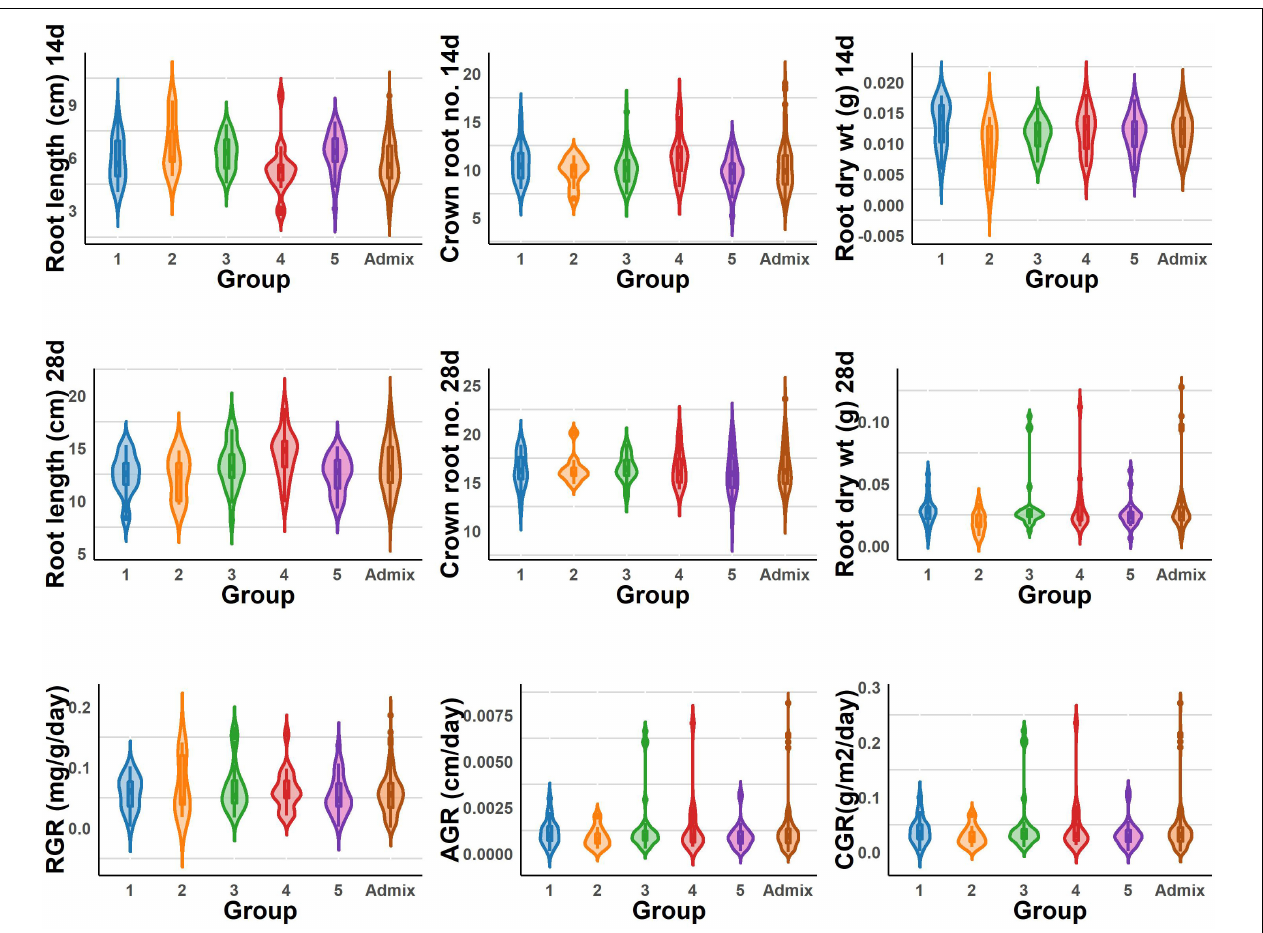
FIGURE 4 | Violin graph represents the range of root length, dry weight, crown root number of 14 and 28 days, and root vigor index variations under DSR conditions of different BAAP groups in the dry season.